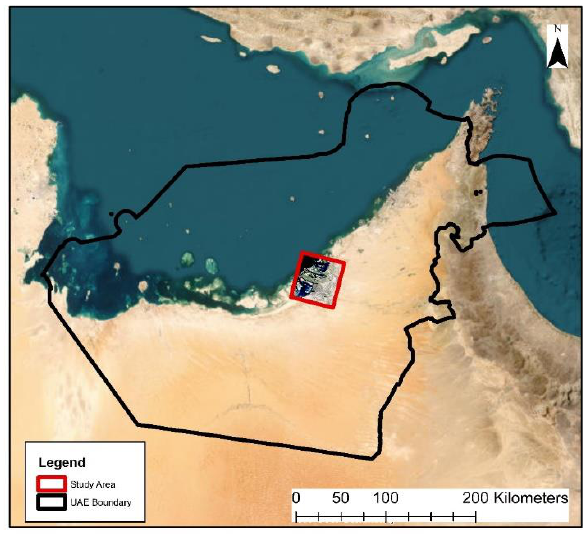
Figure 1. Location map of the study area.